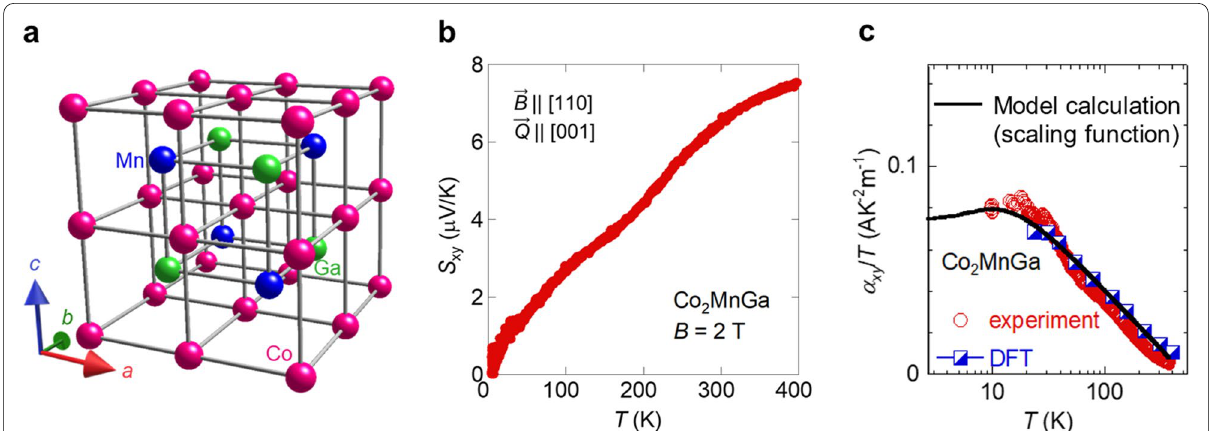
Fig. 4 Giant magneto-thermoelectric effect discovered in the Weyl ferromagnet Co 2 MnGa [15]. a Crystal structure of full-Heusler Co 2 MnGa, b Temperature dependence of the anomalous Nernst coefficient S xy in Co 2 MnGa, and c Temperature dependence of the transverse thermoelectric coefficient divided by temperature α xy T in Co 2 MnGa. The theoretical calculations (blue) show a logarithmic temperature dependence above 20 K, corresponding to the quantum Lifshitz transition shown in Fig. 5. The results are in general agreement with the experimental values (red)